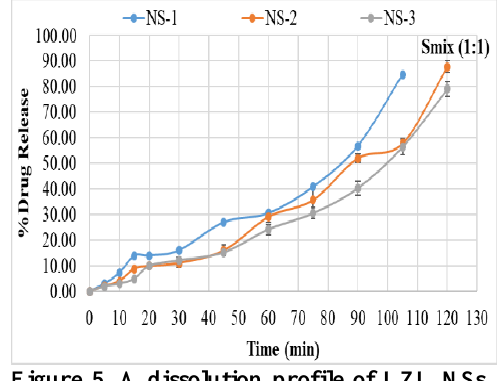
Figure 5. A dissolution profile of LZL NSs (NS-1, NS-2 and NS-3) in 900 ml of 6.8 pH dissolution medium at 37 °C, all the results represent mean ± SD, where n=3